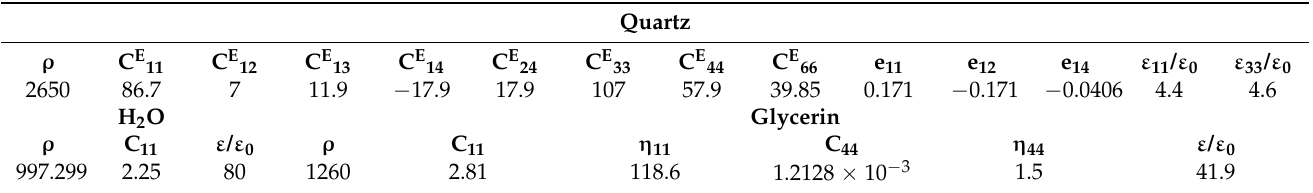
Table 1. Density ρ (kg/m 3 ), elastic constants C ij (GPa), piezoelectric coefficients e ij (C/m 2 ), viscosity coefficients η ij (Pa × s) and dielectric permittivity ε ij / ε 0 of quartz, distilled H 2 O and glycerin used in calculations (T = 22.5 ◦